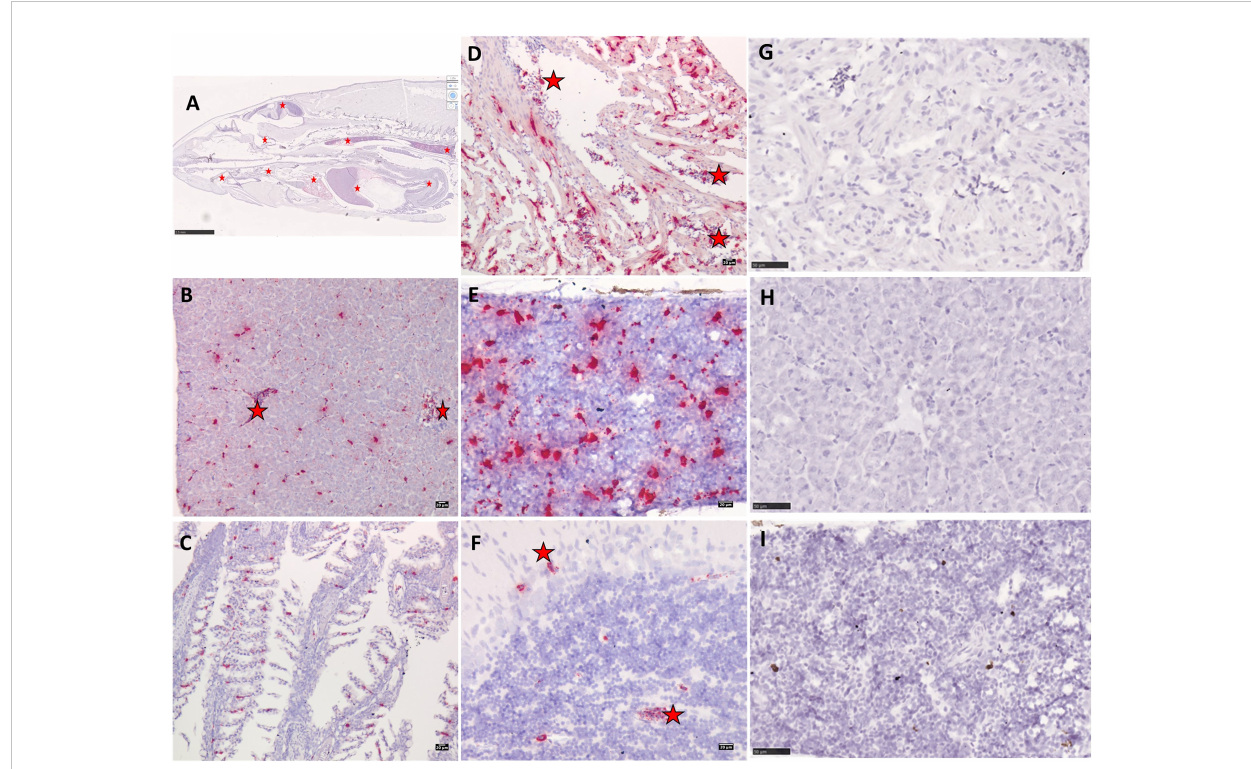
FIGURE 8 Micrographs showing PRV-1 in situ staining of bath challenged Atlantic salmon (A) whole fry at 7WPI. (D) PRV-1 positive staining in heart ventricle cardiomyocytes and erythrocytes. (B) Liver showing positive staining in erythrocytes and hepatocytes. (E) In head kidney, PRV-1 staining is observed mainly in melanomacrophages. (C, F) PRV-1 positive erythrocytes in gills and brain. PRV-1 bath challenged Atlantic salmon tissues stained with negative control ISH probes (G) heart ventricle (H) liver (I) head kidney. PRV-1 positive staining in erythrocytes in different organs highlighted in red